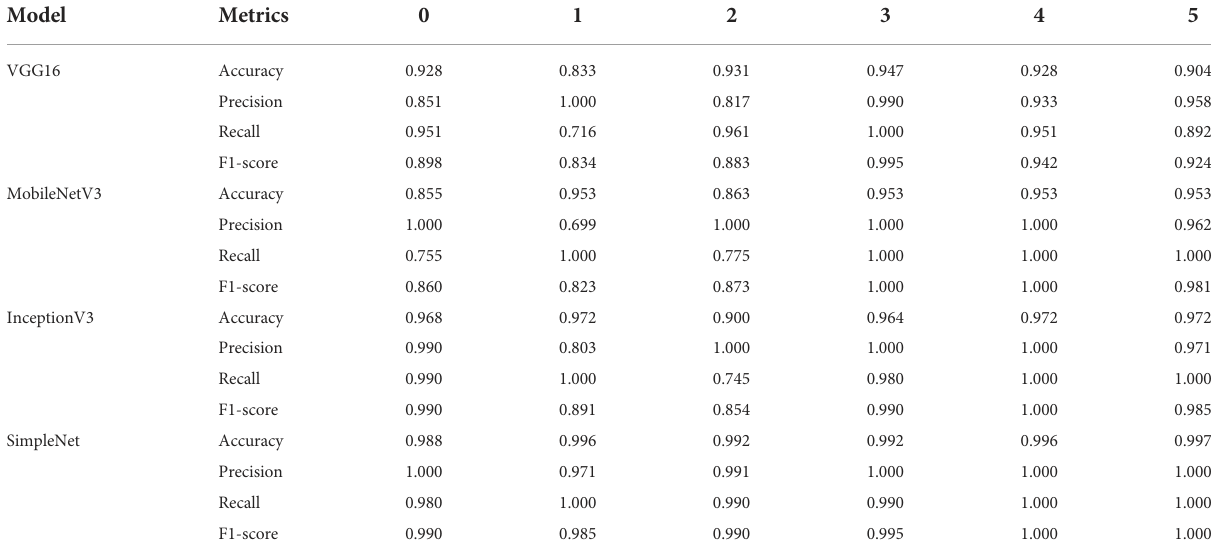
TABLE 8 Evaluation metrics of four CNN models for six kinds of rice leaf diseases.